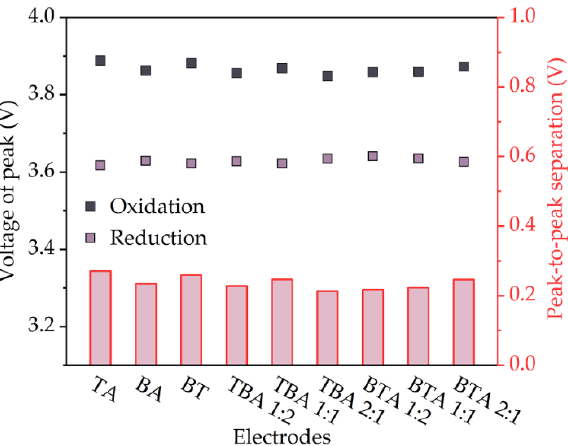
Figure 8. The voltages correspond to redox peaks and the separation of two peaks from CV measurement of cells with different electrodes.